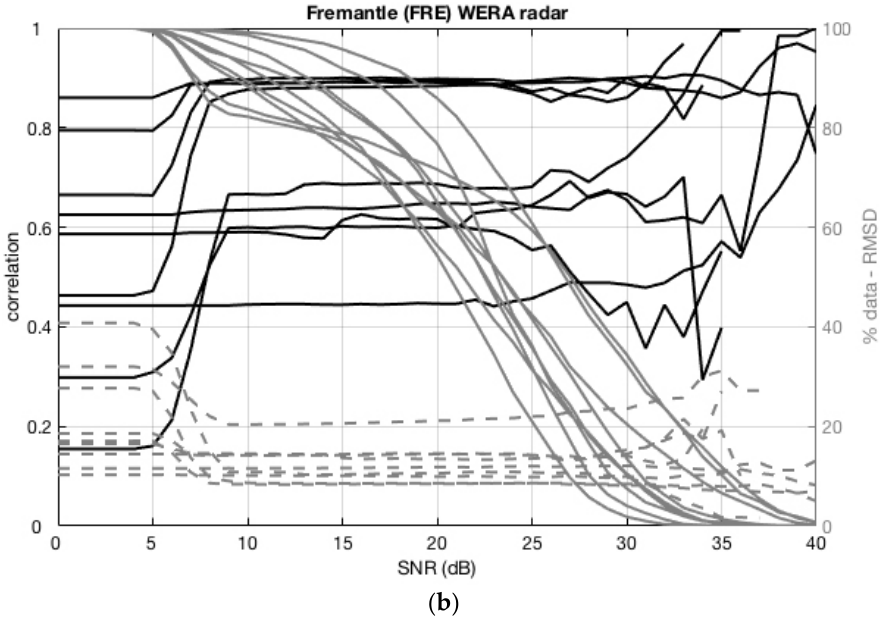
Figure 3. Correlation (R; black solid lines), RMSD (dashed grey lines), and percent data available (solid grey line) as a function of different SNR threshold values for ( a ) GUI and ( b ) FRE HFR stations, for all the mooring deployments in Figure 1. Units for RMSD are cm/s.